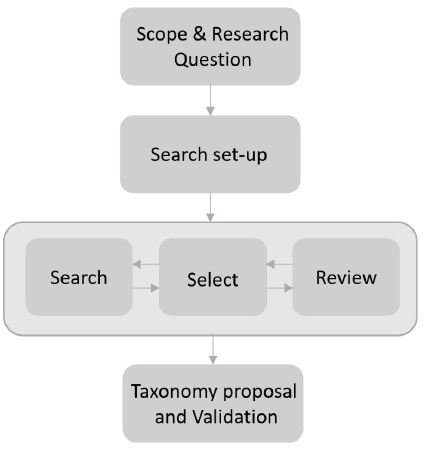
Figure 4. Steps followed to build the proposed